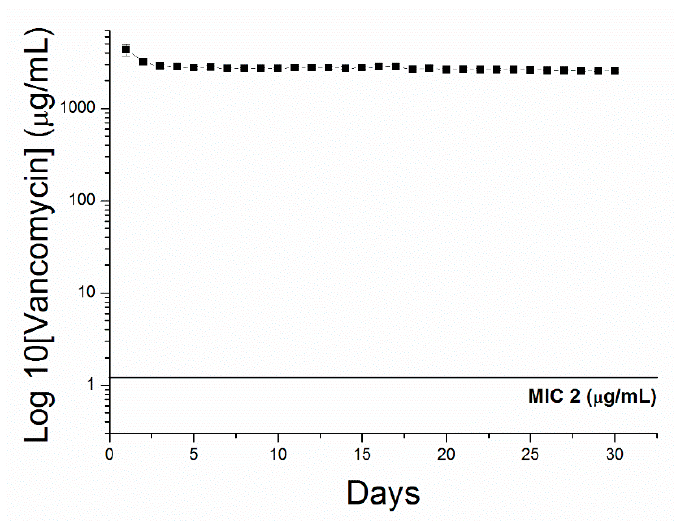
Figure 4. In vitro release. In vitro release of vancomycin from biodegradable antibiotic-embedded microparticles (solid line is the minimum inhibitory concentration (MIC) of vancomycin).